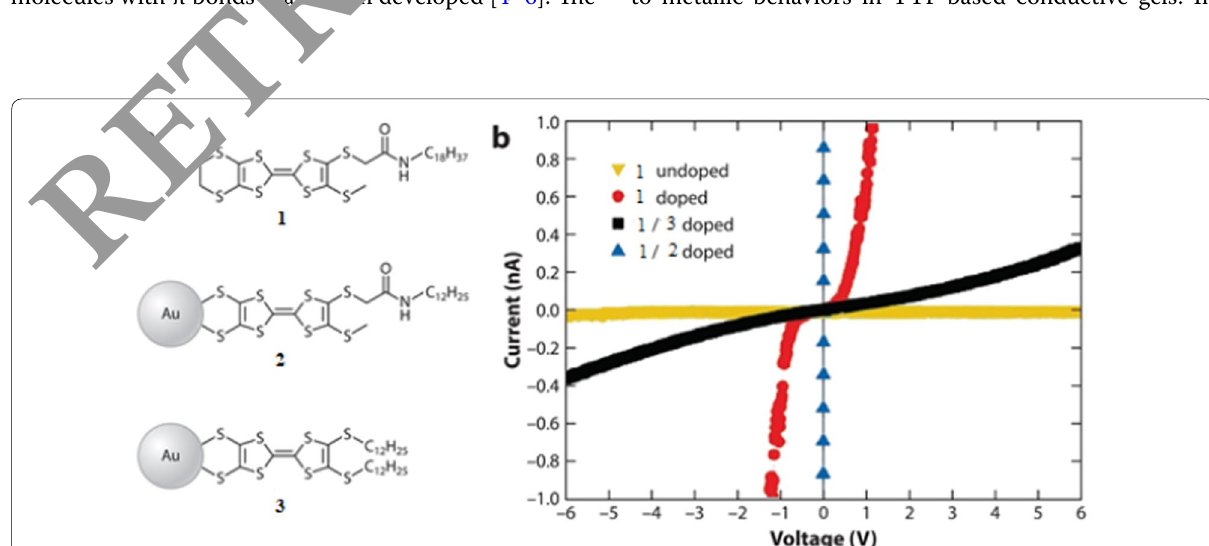
Fig. 1 a Molecular structure of tetrathiafulvalene (TTF)-based conductive gels; b current–voltage diagrams obtained by atomic force microscopy (AFM) for conductive gels in the presence and absence of structures 2 and 3 and doping conditions with I 2